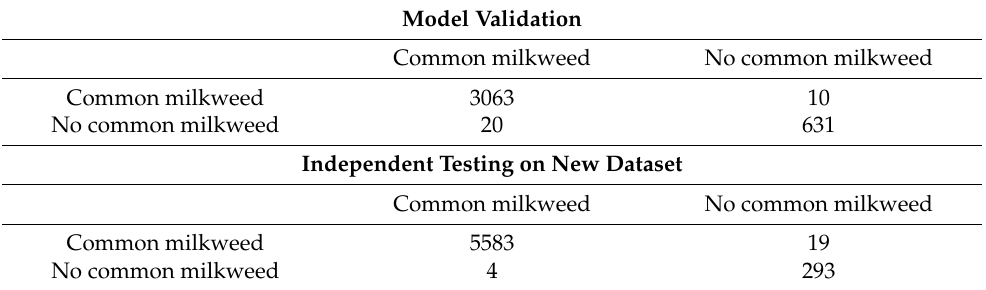
Table 4. Validation of the ANN method.